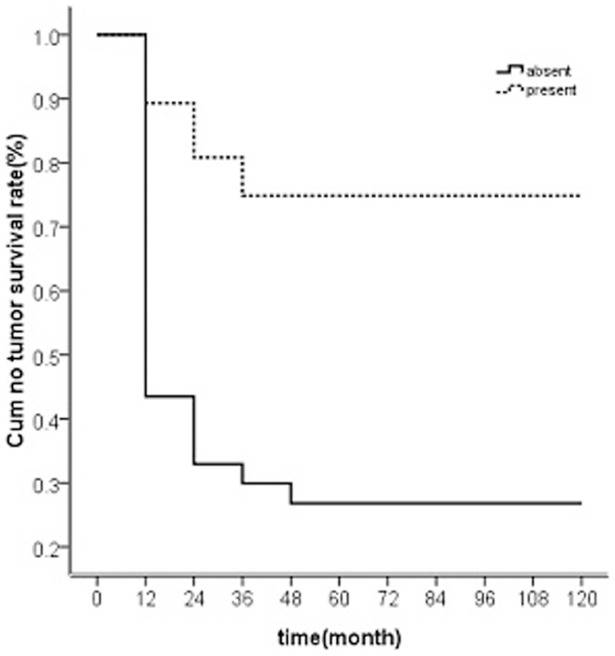
Kaplan-Meier analysis of the recurrence-free survival rates of patients with and without antitumor therapy pre-LT in the exceeding UCSF group.